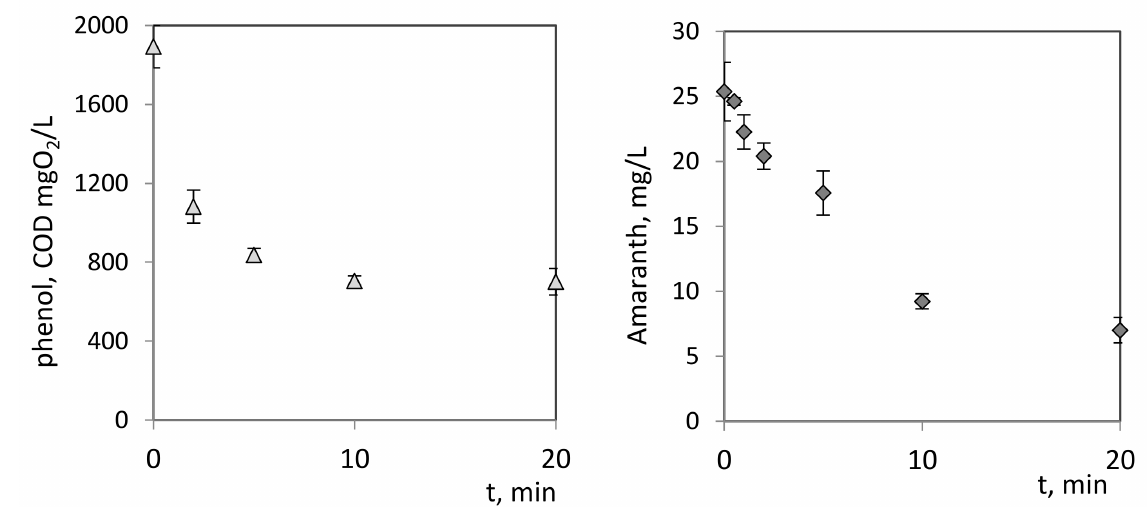
Figure 6. Variation in concentration of xenobiotic organic compounds—phenol, measured as COD ( left ), and amaranth ( right )—after cold plasma